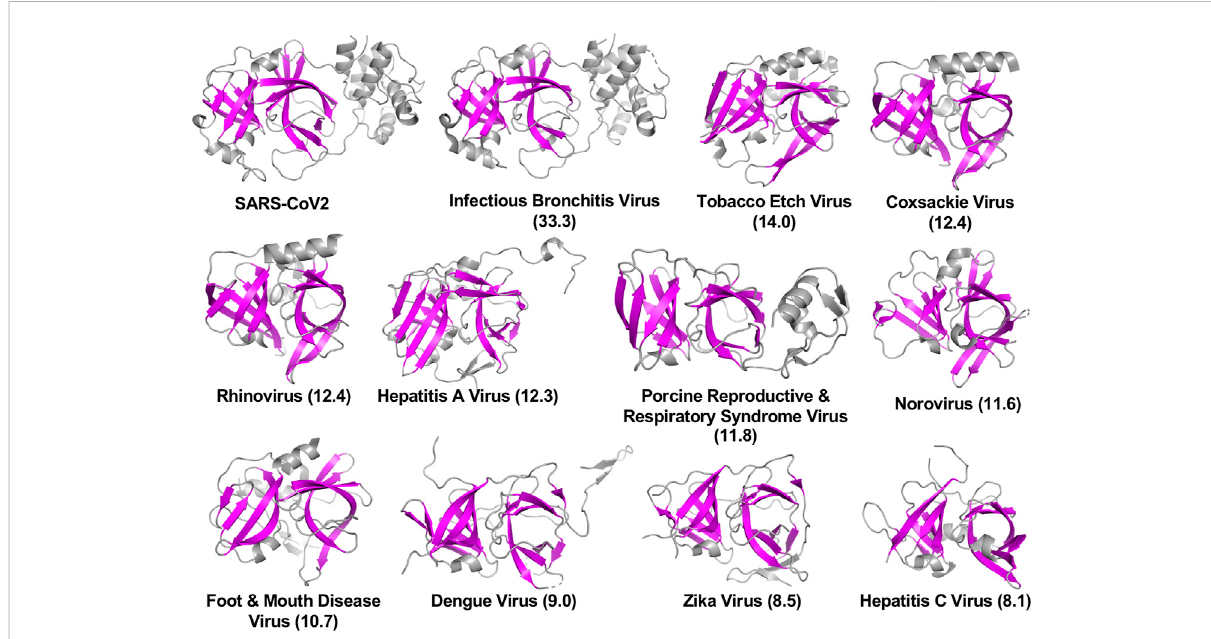
FIGURE 2 Three-dimensional structures of viral proteases that have the double β -barrel fold like the SARS-CoV2 3CL pro . The β -strands forming the characteristic β -barrels are colored in magenta. Other secondary structure elements are shown as cartoon representation colored in gray. Dali Z scores to SARS-CoV2 3CL pro are shown in